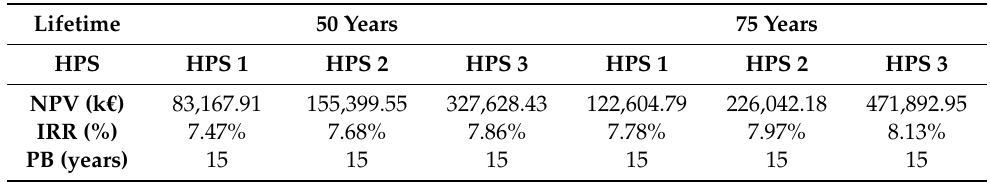
Table 6. Profitability analysis of HPS 1, HPS 2 and HPS 3, making use of existing infrastructure and considering DTCs of 8 h and lifetimes of 50 and 75 years.